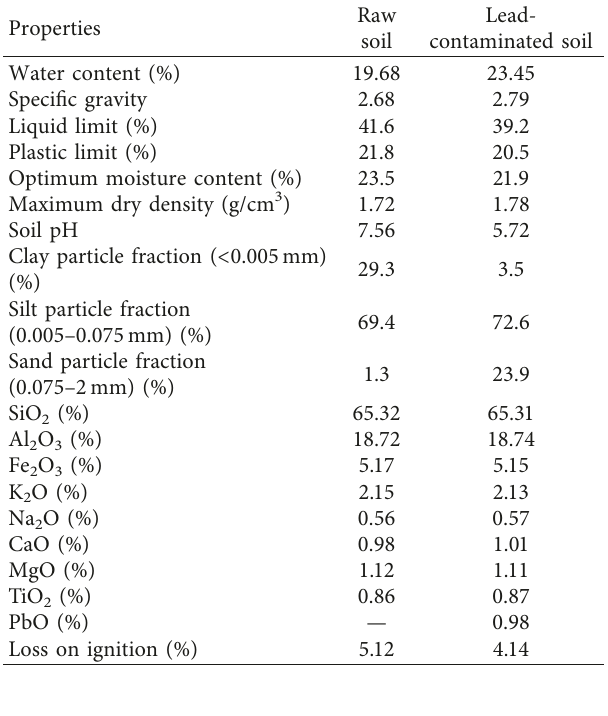
Table 2: Physicochemical properties of soil used in this study. Properties